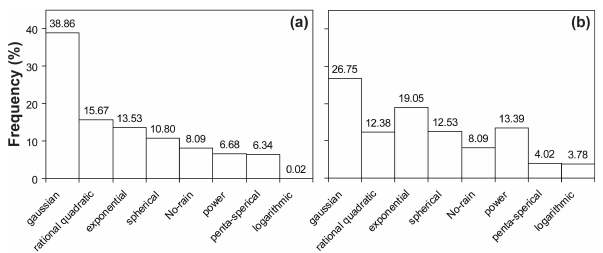
Fig. 5. Occurrence of variogram models used for kriging of the 30-yr dataset. (a) : the best fitted models; (b) : the chosen models avoiding negative